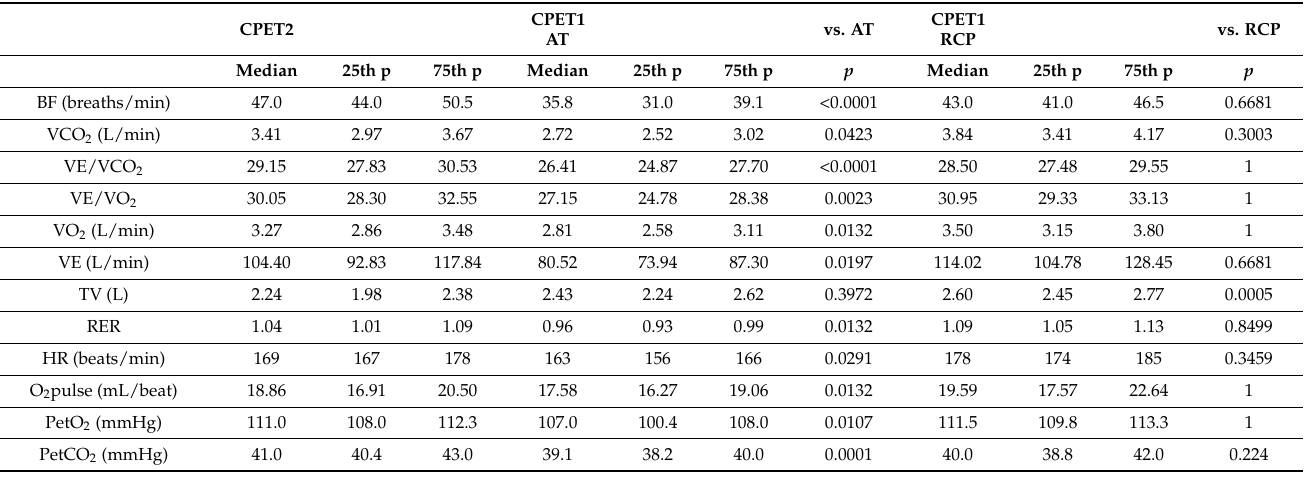
Table 3. Absolute values of CPET parameters during CPET2 (run with vAT with +12 kg weight vest) and CPET1 (AT, RCP). CPET1 AT vs. AT